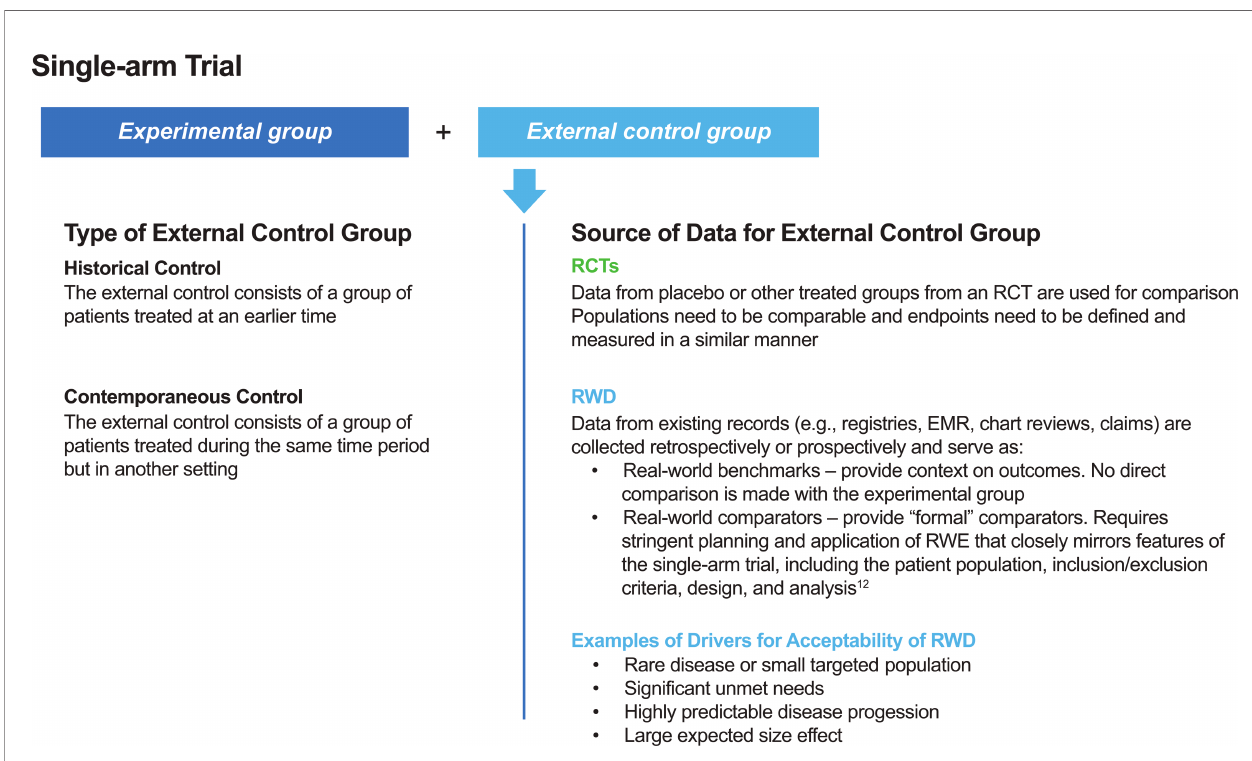
FIGURE 1 | Types of external control groups and sources of data for external control groups. EMR, electronic medical record; RCT, randomized controlled trial; RWD, real-world data; RWE, real-world